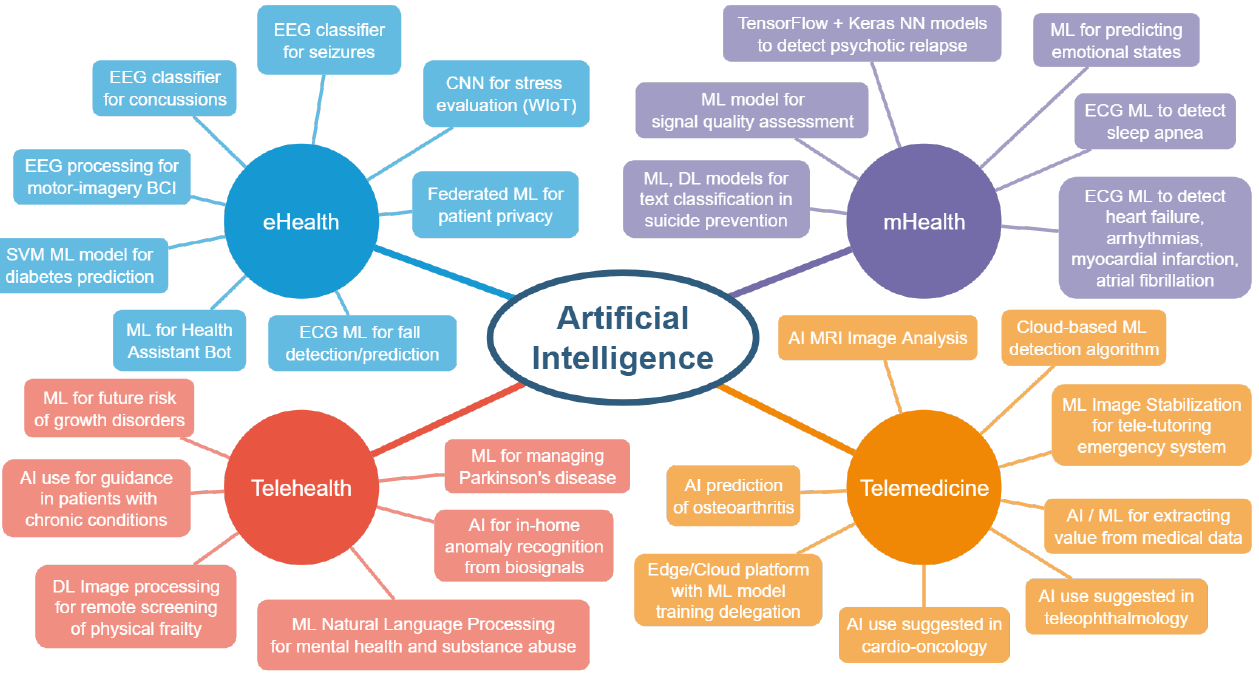
Figure 1. Artificial intelligence utilization in eHealth.